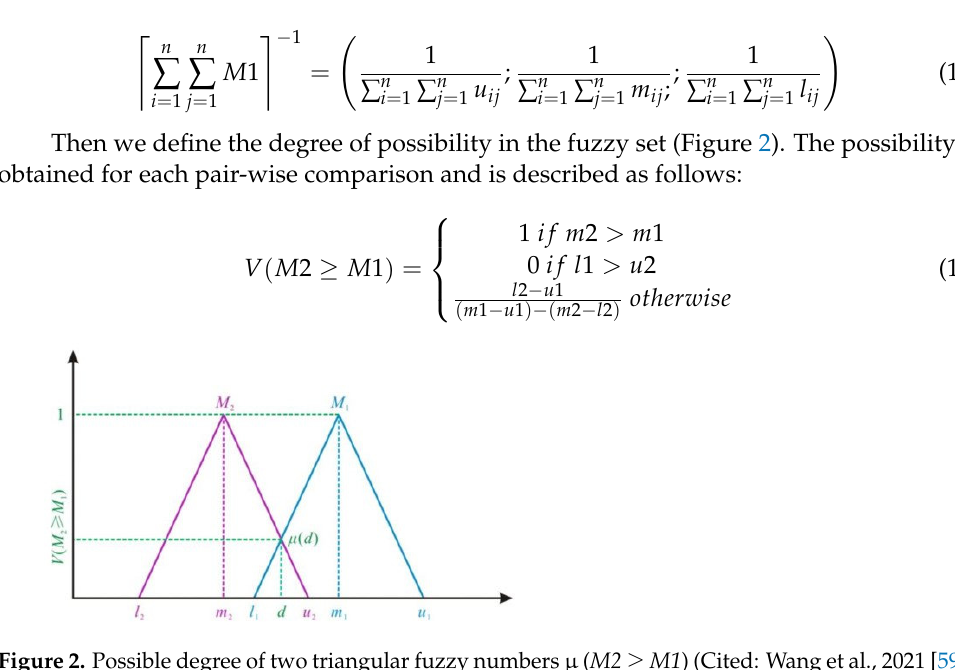
Figure 2. Possible degree of two triangular fuzzy numbers μ ( M2 ≥ M1 ) (Cited: Wang et al., 2021 [59]).